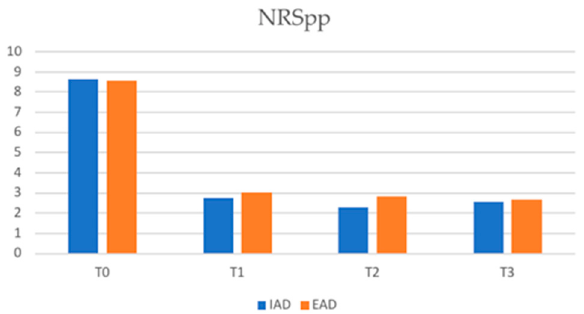
Figure 3. Numerical rating scale pick pruritus (NRSpp) in IAD and EAD patients (IAD = intrinsic atopic dermatitis; EAD = extrinsic atopic dermatitis).